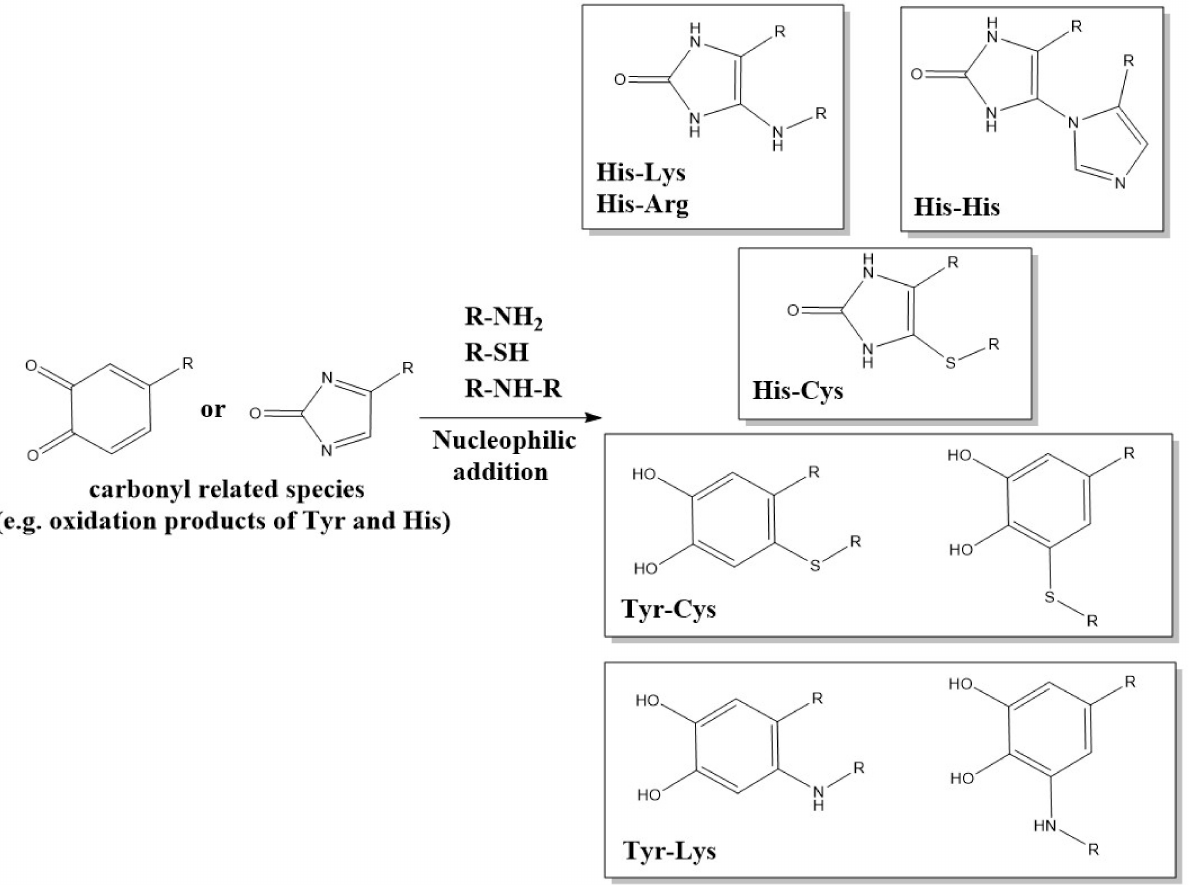
Figure 7. Michael addition reactions of amino acid side-chains to oxidized His and Tyr residues. Related Michael reactions occur with Tyr-derived quinones formed on oxidation of Tyr residues, with nitrogen nucleophiles, such as the N ε -amine of Lys side-chains undergoing adduction reactions with the oxidized ring (Figure 7). These reactions occur with